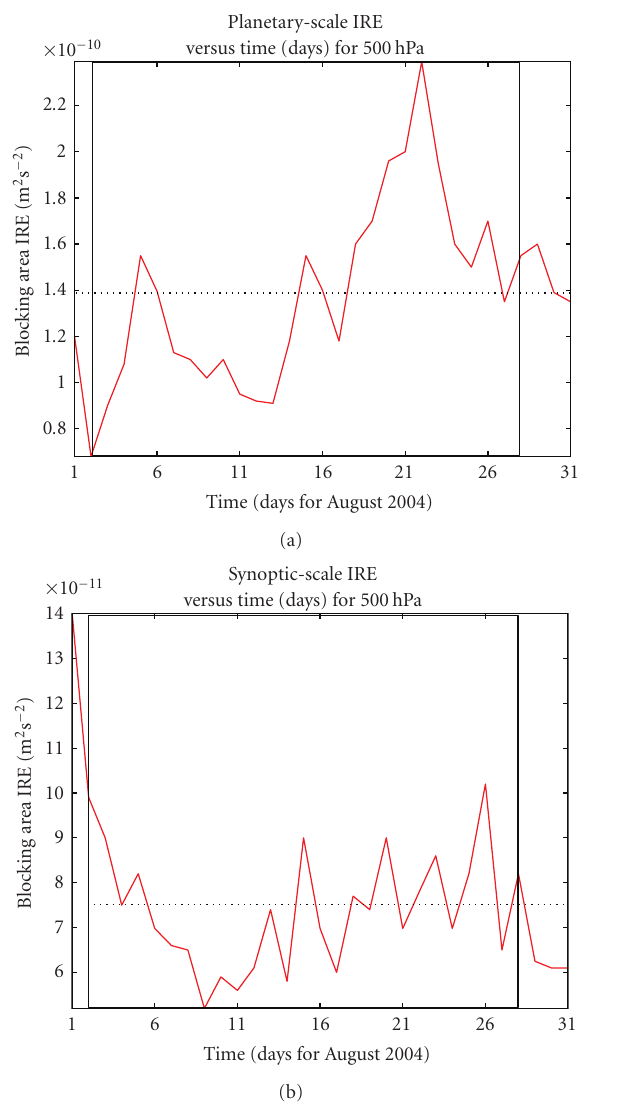
Figure 6: (a) The 500 hPa planetary-scale max |∇ ψ | versus time (days) for a stationary box (40 ◦ N to 80 ◦ N and 160 ◦ E to 260 ◦ E) in the midlatitude northern hemispheric flow. The dash dotted line defines the mean monthly value for max |∇ ψ | . The left vertical line marks the beginning, whereas the right vertical line marks the end of the selected blocking event; (b) same as Figure 6(a) except that now the synoptic-scale e ff ect is taken into